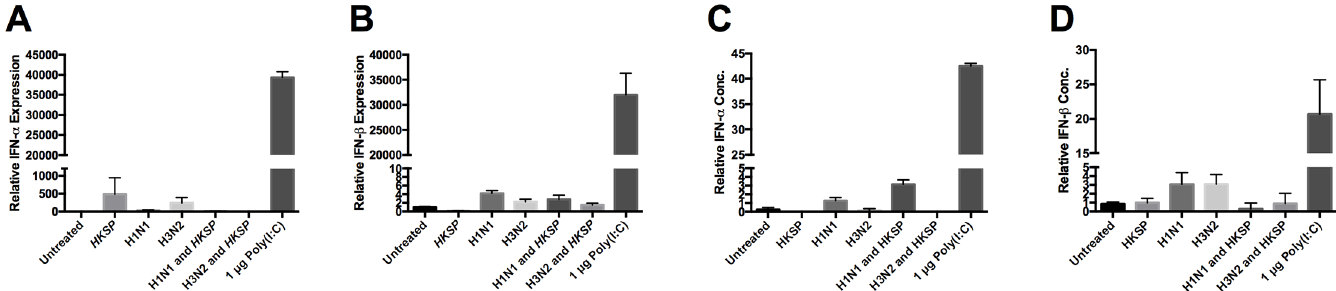
Fig 2. Modulation by IAV of innate and adaptive responses to Pneumococcus is not due to Type I IFN production. (A) IFN- α (n = 4) and (B) IFN- β (n = 3) mRNA production in CD14 + cells following 24 h treatment with HKSP, live H1N1 or H3N2 alone or in combination with HKSP (or untreated as a control), or 1 μ g Poly(I:C) transfected with LyoVec solution. mRNA expression of IFN- α , IFN- β , and GAPDH from infected and control treatments was determined by qPCR. The level of IFN- α (n = 3) (C) and IFN- β (n = 3) (D) protein secreted by CD14 + cells following 24 h treatment with HKSP, live H1N1, H3N2 alone or in combination with HKSP or Poly(I: C) (or untreated as a control) were determined by